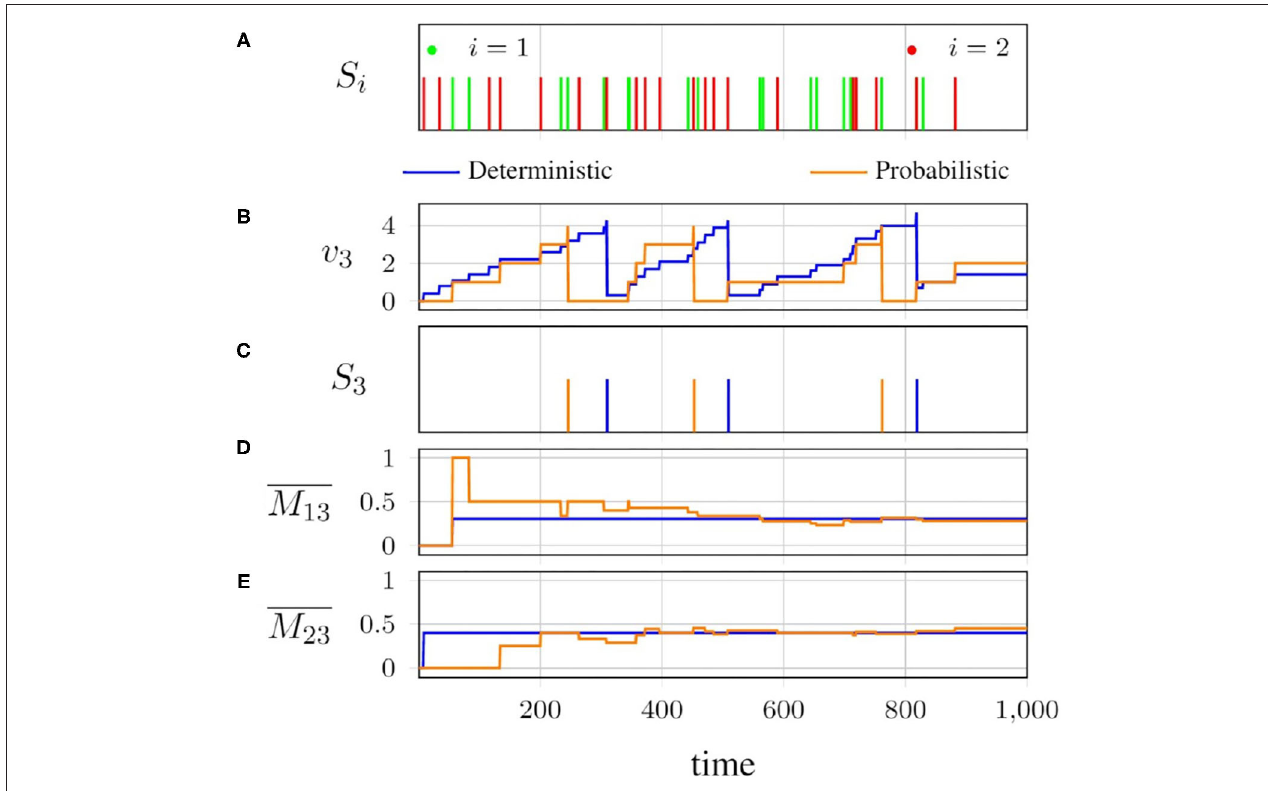
FIGURE 4 | Behavior of the network in Figure 3 : (A) spike patterns of neurons 1 and 2; (B) membrane potential of neuron 3; (C) consequent spike pattern of neuron 3; (D,E) average potentiation of neuron 3, by neurons 1 and 2, respectively, with deterministic and probabilistic ( p ij = w ij ; ˆ w ij = 1) spike propagation.